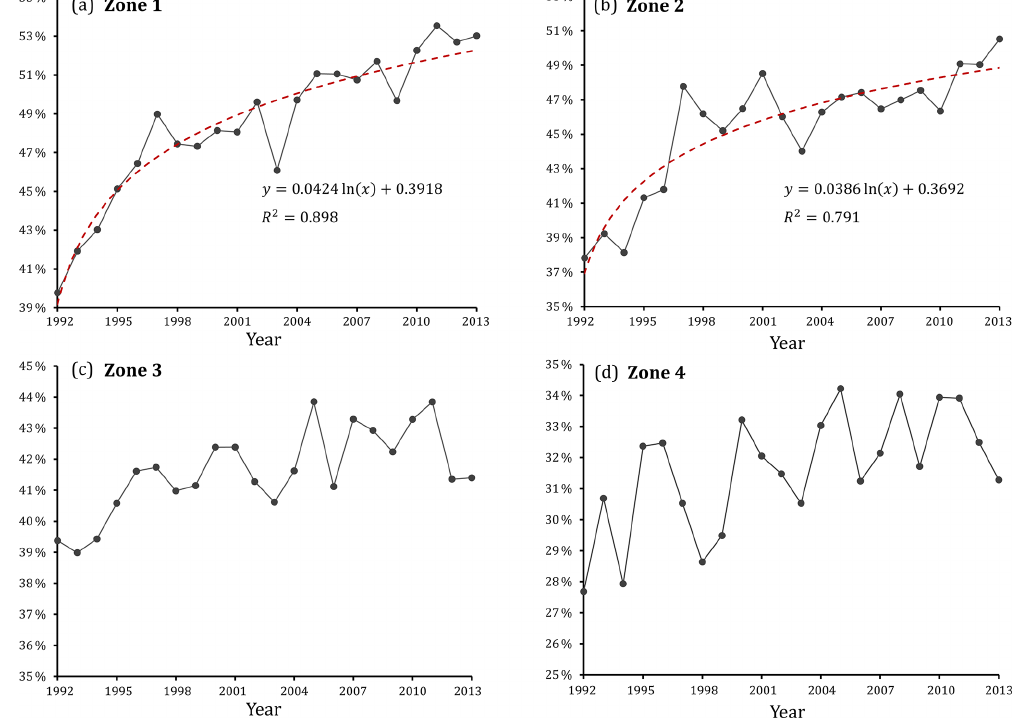
Figure 6. Yearly statistics of percent area with VANUI values larger than 0 in (a) Zone 1, (b) Zone 2, (c) Zone 3 and (d) Zone 4. In (a) and (b) , the independent variable x in the logarithmic regression model denotes the year sequence starting from 1992, meaning that x = 1 denotes the year 1992, x = 2 denotes 1993, and so on.